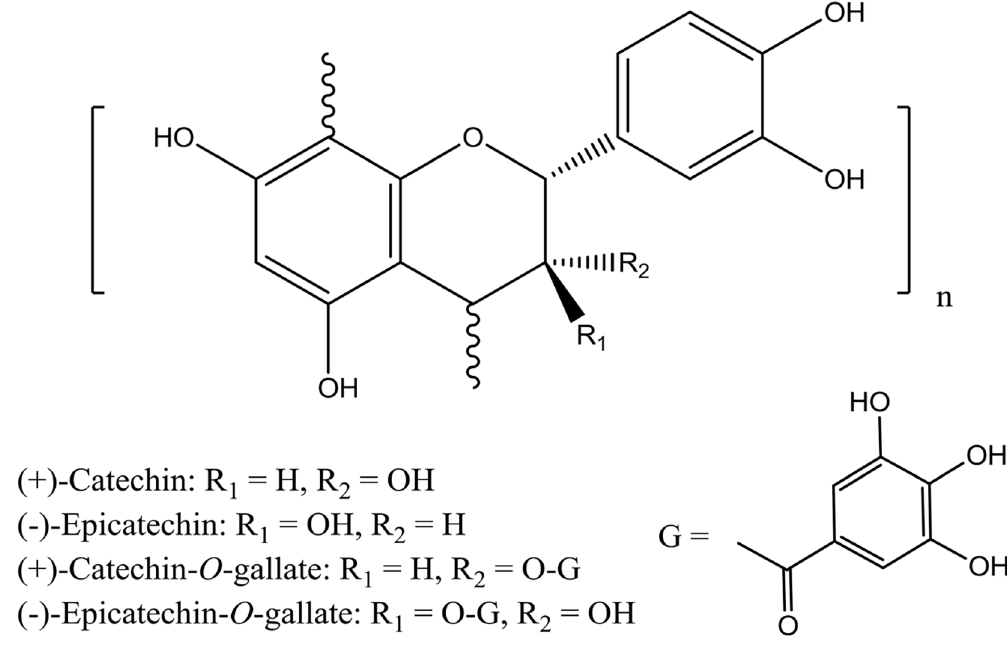
Fig 1. Subunits structures of tannins from grape